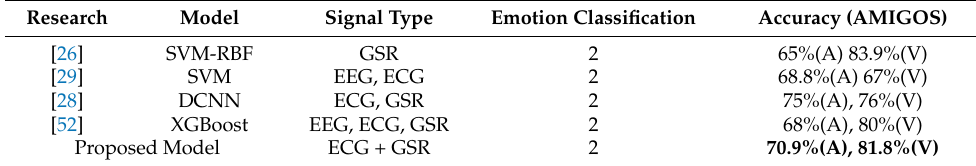
Table 3. Accuracy comparison with other similar